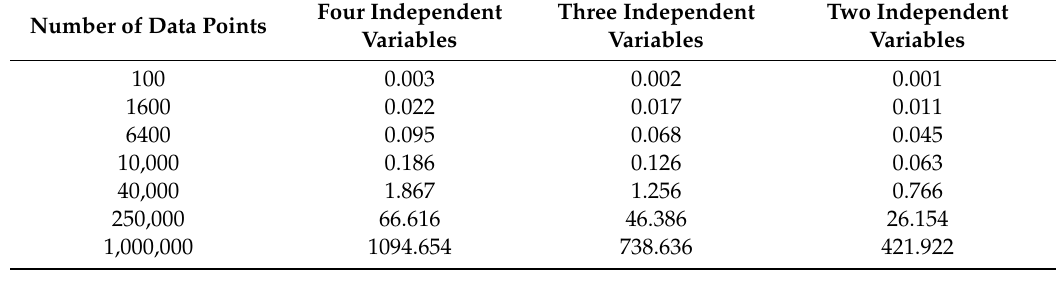
Table 2. Runtime (in seconds) for di ff erent numbers of coe ffi cients using di ff erent numbers of data points.